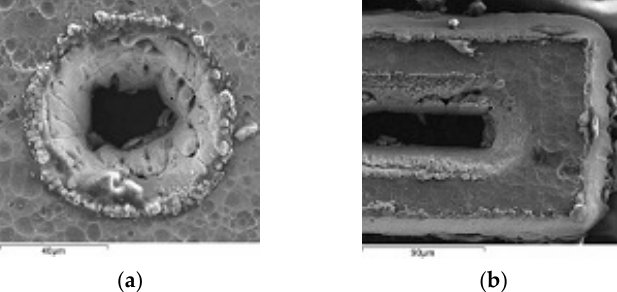
Figure 2. Typical ablation results for the described laser-cutting process for fast ablation: ( a ) hole for galvanic rivets before wet etching (SEM image); ( b ) detail of an SMA spring structure before wet etching (SEM image).